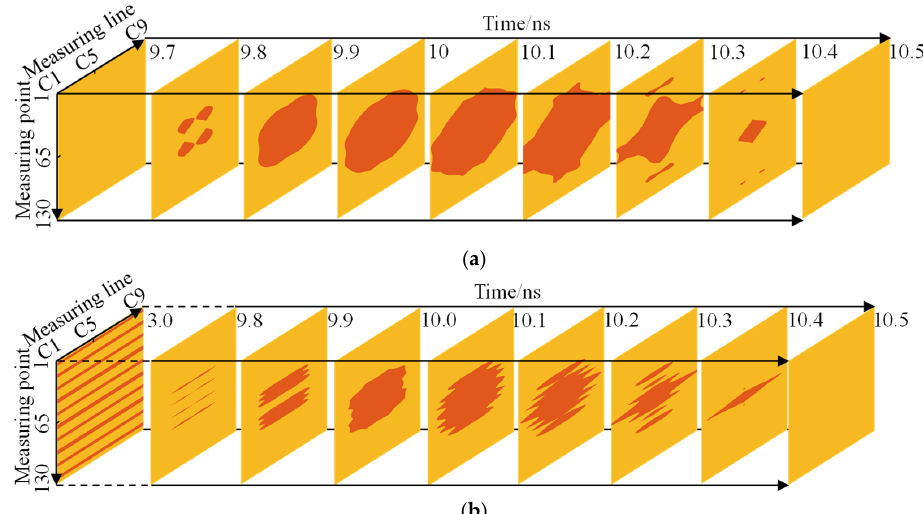
Figure 18. Slices along the horizontal direction: ( a ) Support A, ( b ) Support B. This figure illustrates that the response of the center of the cavity is the